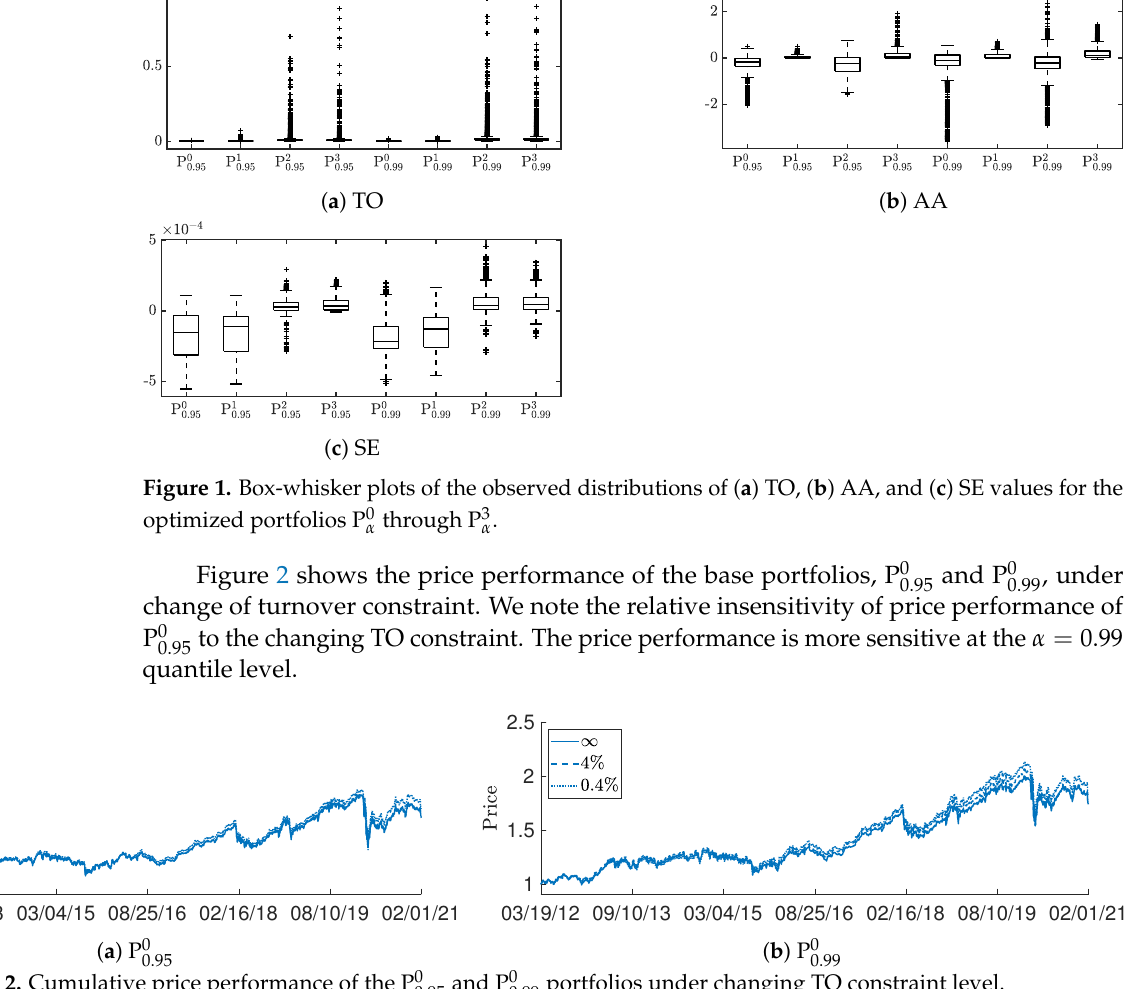
and P 0 portfolios under changing TO constraint 0.95 0.99